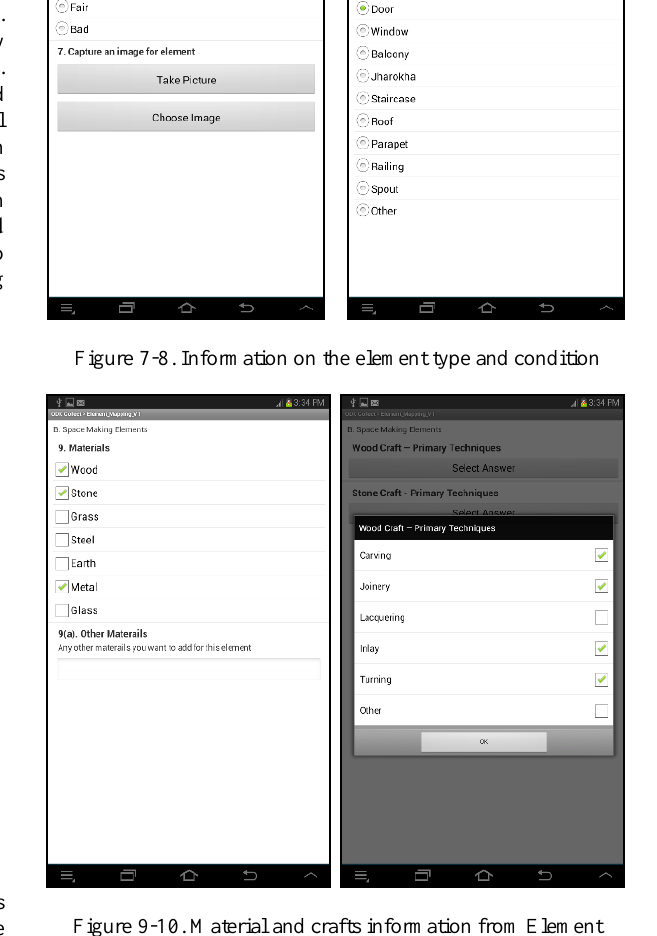
Figure 9-10. Material and crafts information from Element Mapping